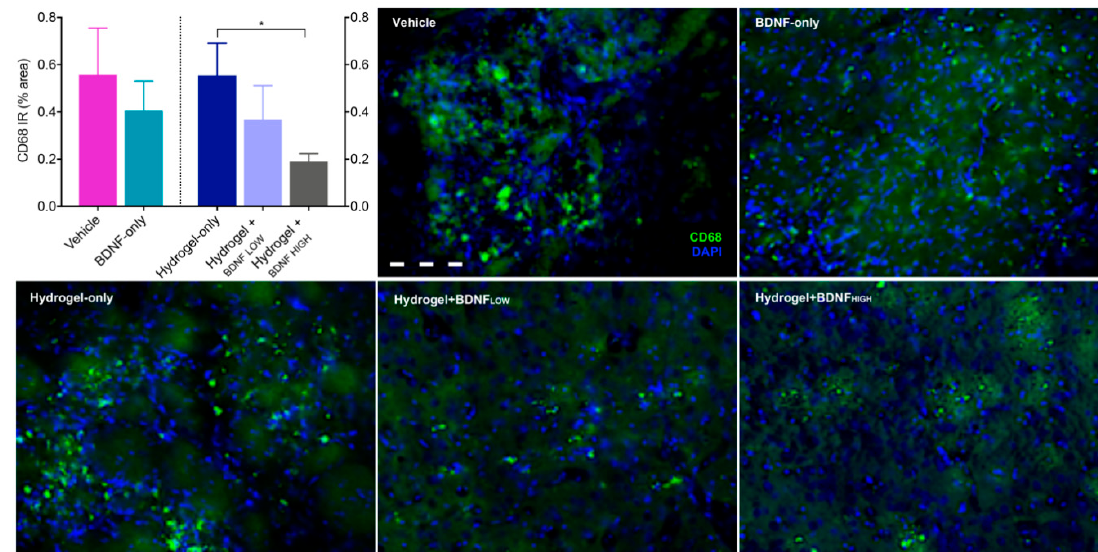
Figure 5. Effects of BDNF and delivery vehicle on phagocytosis following dMCAo. Hydrogel + BDNF HIGH treatment reduces levels of CD68 in the ipsilateral corpus striatum. Representative photomicrographs of CD68 (green) and DAPI nuclear stain (blue) at 20 × magnification from each treatment group are shown in neighboring panels. Vehicle ( n = 5), BDNF-only ( n = 5), hydrogel-only ( n = 5), hydrogel + BDNF LOW ( n = 5), and hydrogel + BDNF HIGH ( n = 5). Scale bar = 20 µm. IR = immunoreactivity. Error bars indicate the mean ± SEM; * p < 0.05.